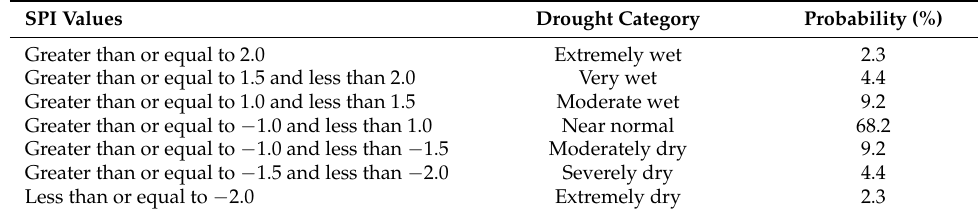
Table 2. Categorization of different states of SPI. SPI Values Drought Category Probability (%) Greater than or equal to 2.0 Greater than or equal to 1.5 and less than 2.0